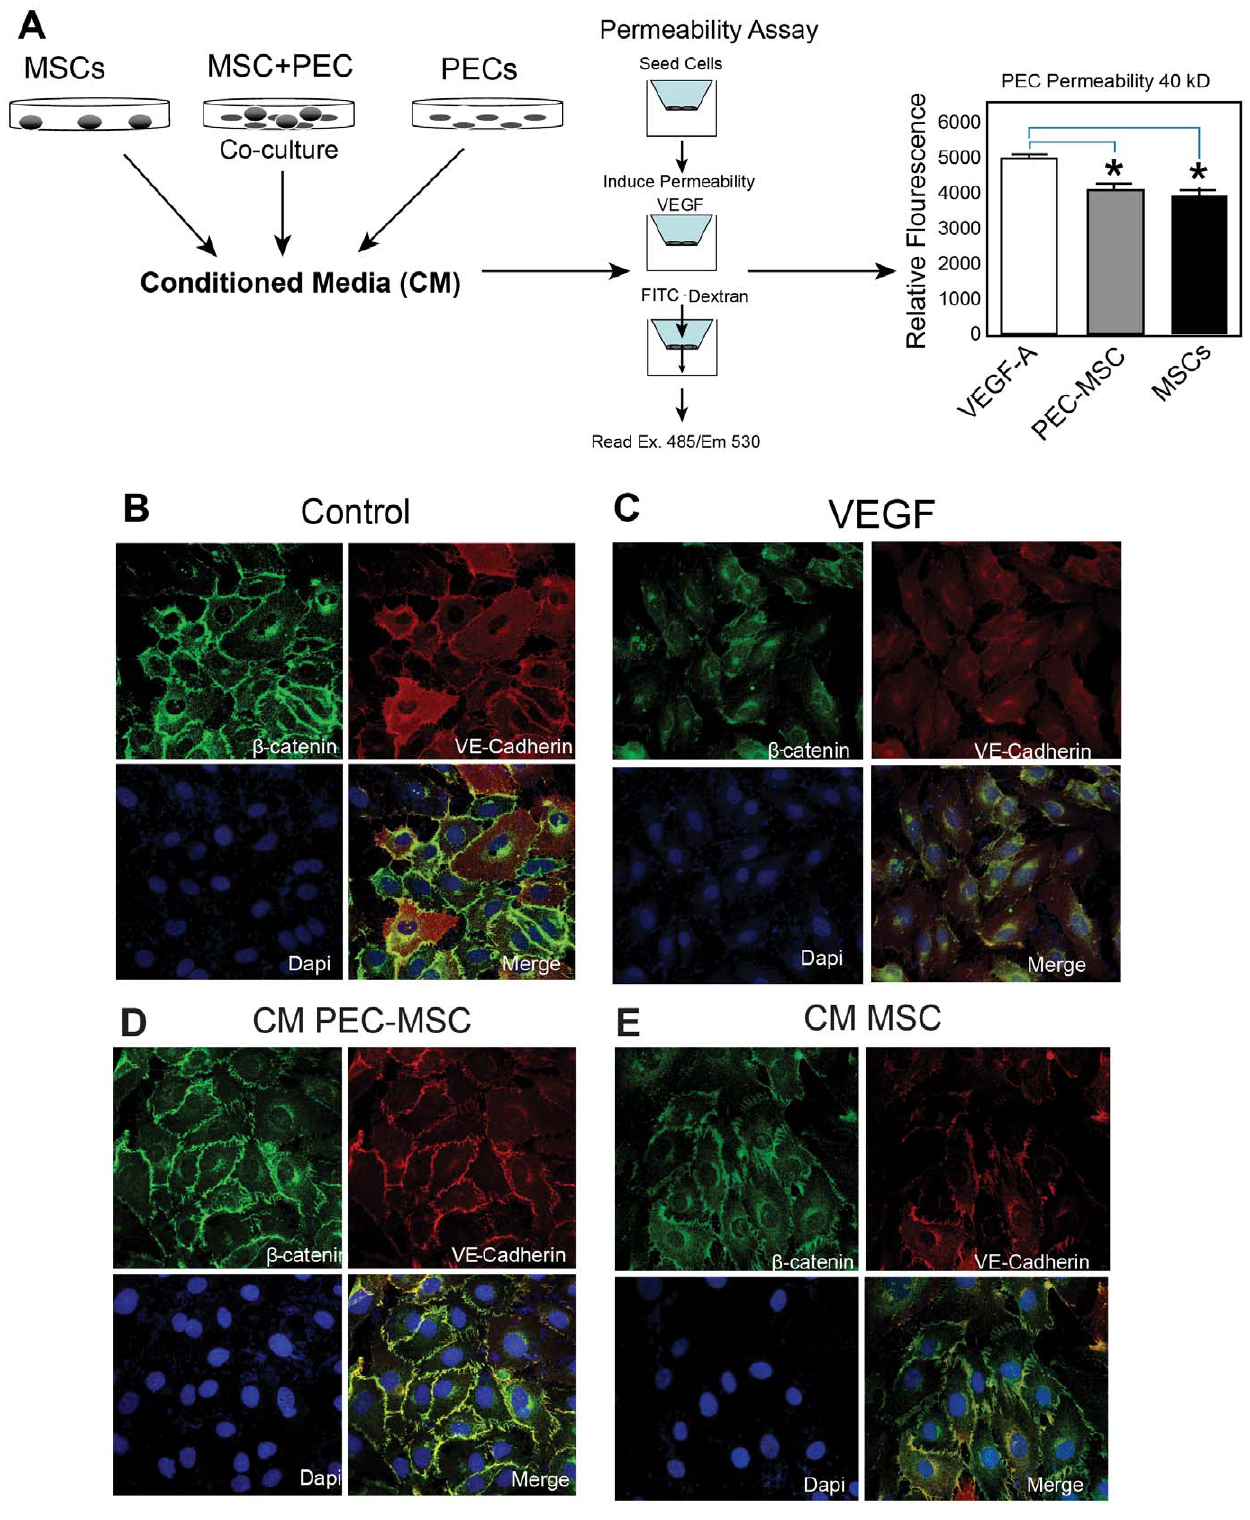
Figure 1. Conditioned media (CM) inhibits permeability and restores adherens junctions (AJs). Figure 1A, CM from MSCs and MSC-PEC co-cultures inhibits PEC permeability in vitro . A schematic depicting how CM is prepared is shown. MSCs and PECs are cultured separately and together in co-culture. CM is collected 24 hours later and used in a transwell assay of PEC permeability to 40 kD FITC-Dextran. Figure 1A shows that CM from both MSCs and MSC-PEC co-cultures inhibits permeability induced by VEGF-A (10 ng/ml). (*) signs indicate significance p , 0.05 between MSC and VEGF and MSC-PEC and VEGF groups. Figures 1B–E, CM from MSCs and MSC-PEC co-cultures restore AJs. PECs were cultured overnight. After 24 hours, breakdown of AJs ( b -catenin and VE-Cadherin) is induced by treatment with VEGF-A (10 ng/ml). Cells were subsequently treated with CM. Figures 1B–E show that MSC and MSC-PEC CM restored AJ breakdown as determined by confocal microscopy imaging of cultures stained with antibodies to VE-Cadherin (red) and b -Catenin (green). doi:10.1371/journal.pone.0025171.g001 PLoS ONE |